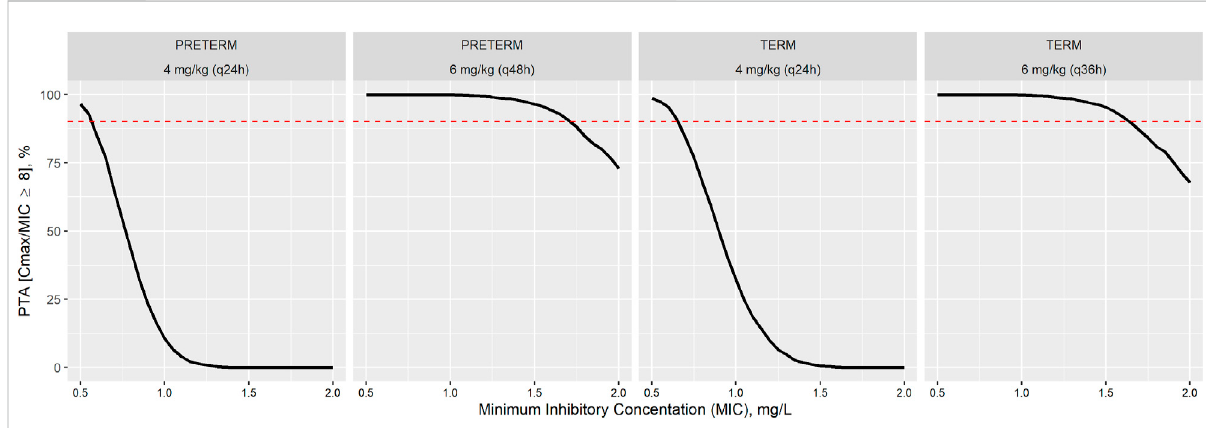
FIGURE 3 Probability of target attainment (PTA) to reach the C max /MIC ≥ 8 ratio for each gentamicin dosage regimen: conventional (4 mg/kg q24h) and extended interval regimen (6 mg/kg q48h and 6 mg/kg q36h for preterm and term,